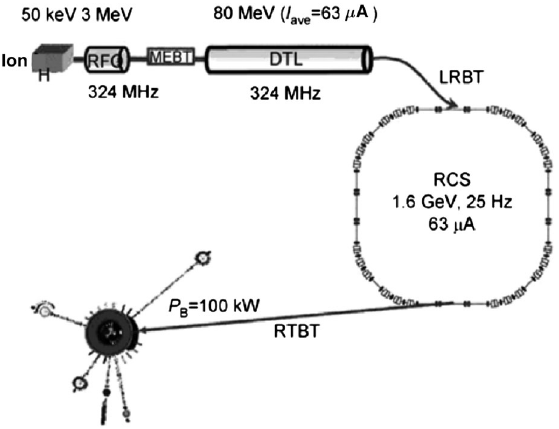
FIG. 1. The schematic layout of